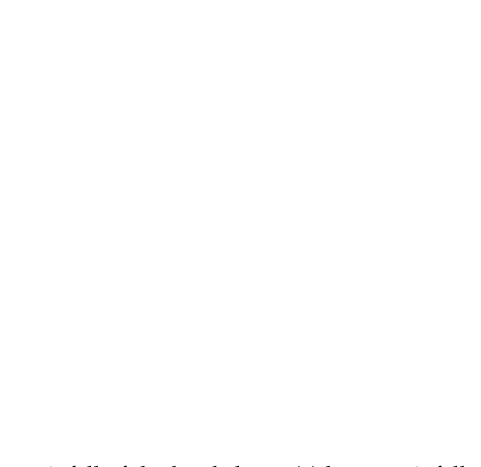
Figure 10. Schematic diagram of failure mode under rainfall of the local slope: ( a ) heavy rainfall, ( b )